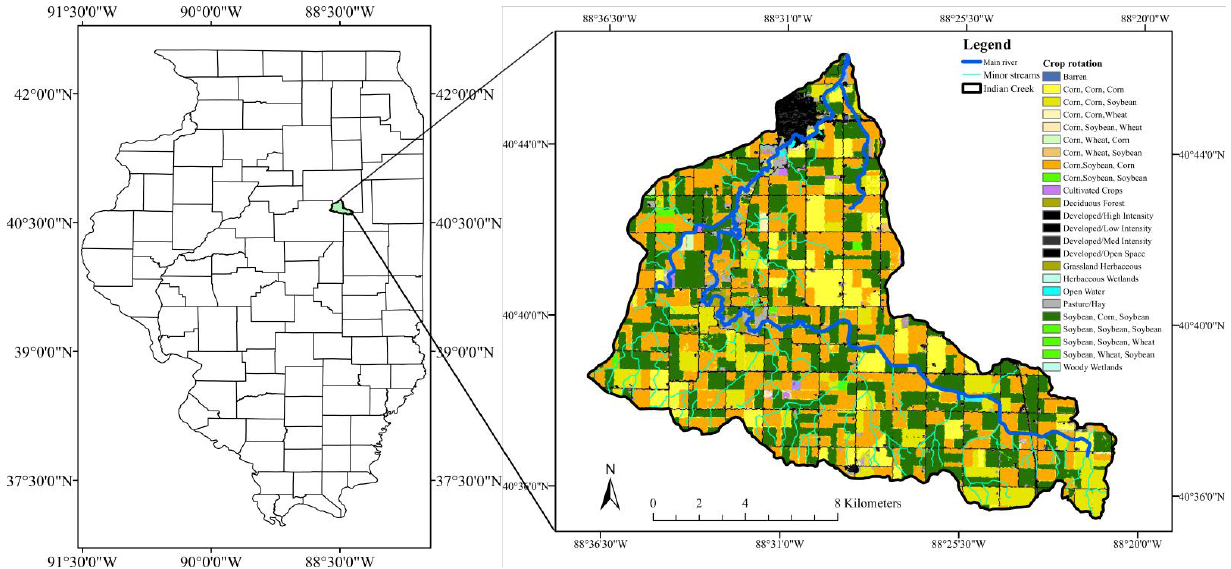
Figure 1. Location of the Indian Creek watershed in the State of Illinois showing the dominant land use and land cover, and three year crop rotations. The watershed drains parts of three Illinois counties of Livingston, Mclean, and Ford into the Vermilion